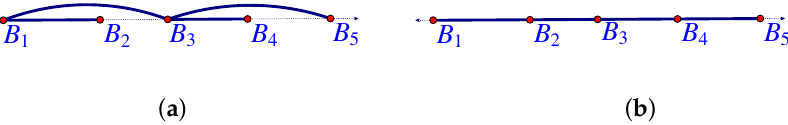
Figure 43. A body-bar framework on the line is infinitesimally rigid if it contains a spanning tree ( a ). Such a tree can be replaced by a path along the line ( b ) by the analogue of substitution principles (Section 8.3) or equivalently by row reduction in the rigidity